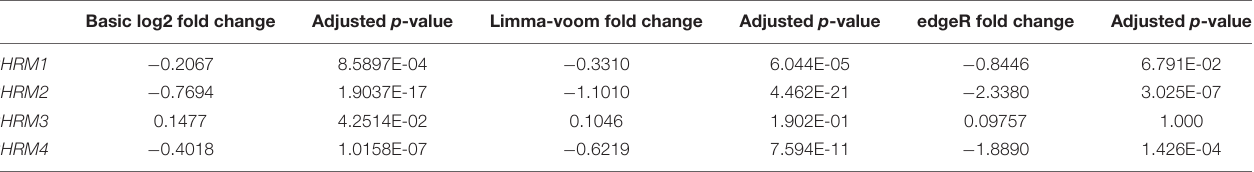
TABLE 2 | Log2 fold changes in